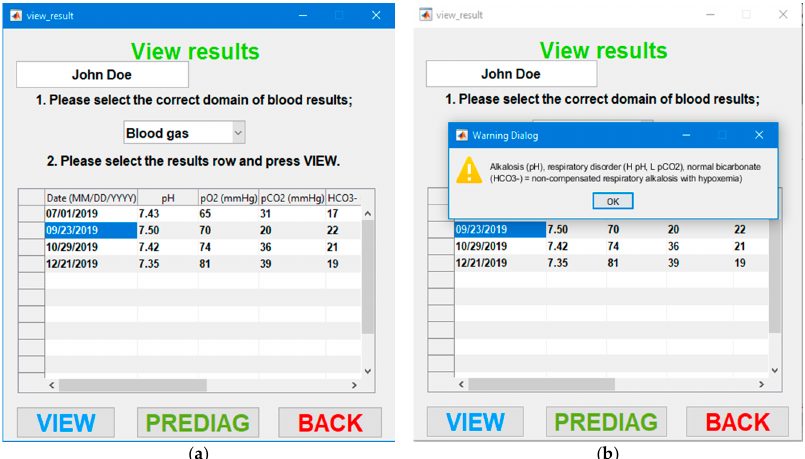
Figure 6. Accessing the stored results: ( a ) View results by domain and date; ( b ) Prediag function of the stored results. For each blood assay domain there are predefined specific rules and messages, de- pending of the results analyzed using the “Prediag” function. If the “View” button is se- lected, the “Result chart” GUI is executed.